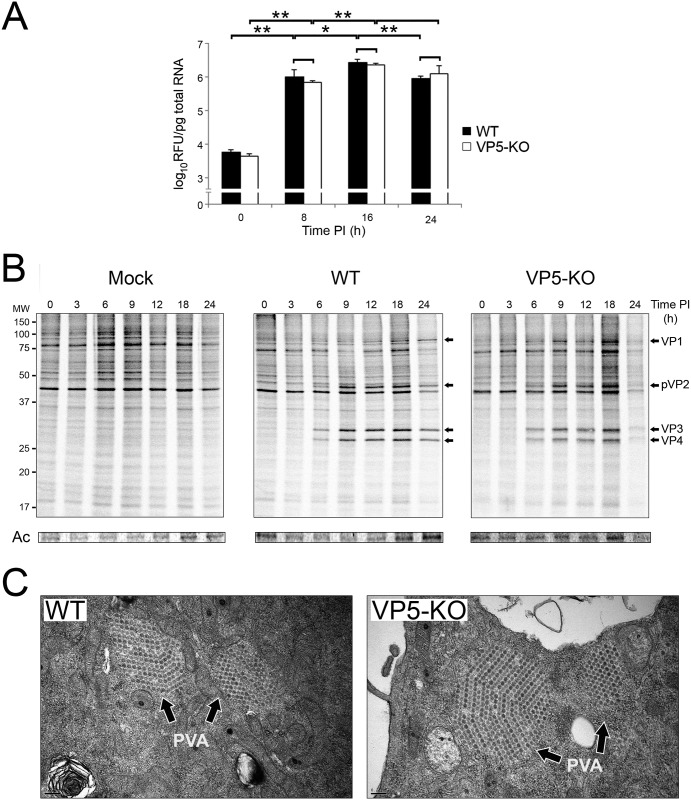
Effect of VP5 abrogation on the IBDV replication program.QM7 cell monolayers were mock-infected (Mock) or infected (MOI of 3 PFU/cell) with the WT or the VP5-KO virus. (A) Accumulation kinetics of IBDV-specific RNAs. Cultures harvested at the indicated times PI were used for the isolation of total RNA. RNA samples were then used for qPCR analysis using primers hybridizing at the VP3 coding region (IBDV genome segment A). Each determination was carried out in triplicate. Presented data correspond to the mean ± the standard deviation of three independent experiments. Black and white bars correspond to data from WT- and VP5-KO-infected cultures, respectively. Brackets indicate pairwise data comparisons. *p<0.01, **p<0.001 as determined by two-tailed unpaired Student’s t-test. (B) Comparative time-course analysis of steady-state protein synthesis. At the indicated times PI, mock-infected (Mock) or infected QM7 cell cultures were metabolically labeled with [35S]methionine for 1 h and then harvested. Cell extracts were subjected to SDS-PAGE. After Coomasie-blue staining, gels were dried and used for autoradiography. Upper panels show autoradiograms. The position of molecular mass markers is indicated (MW). Bands corresponding to major IBDV-encoded polypeptides (VP1 to VP4) are pointed by arrows. Panels below autoradiograms correspond to the 42 kDa actin protein (Ac) as detected in the corresponding Coomasie-blue stained gels. (C) Virus assembly. Representative TEM images from samples corresponding to cells infected with the WT or the VP5-KO virus. Samples were harvested at 8 h PI. Paracrystaline virus arrays (PVA) are indicated by arrows. Bars correspond to 0.2 μm.